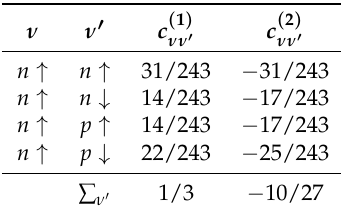
( 1 ) ( 2 ) and c for ν = n ↑ νν (cid:48) νν (cid:48)